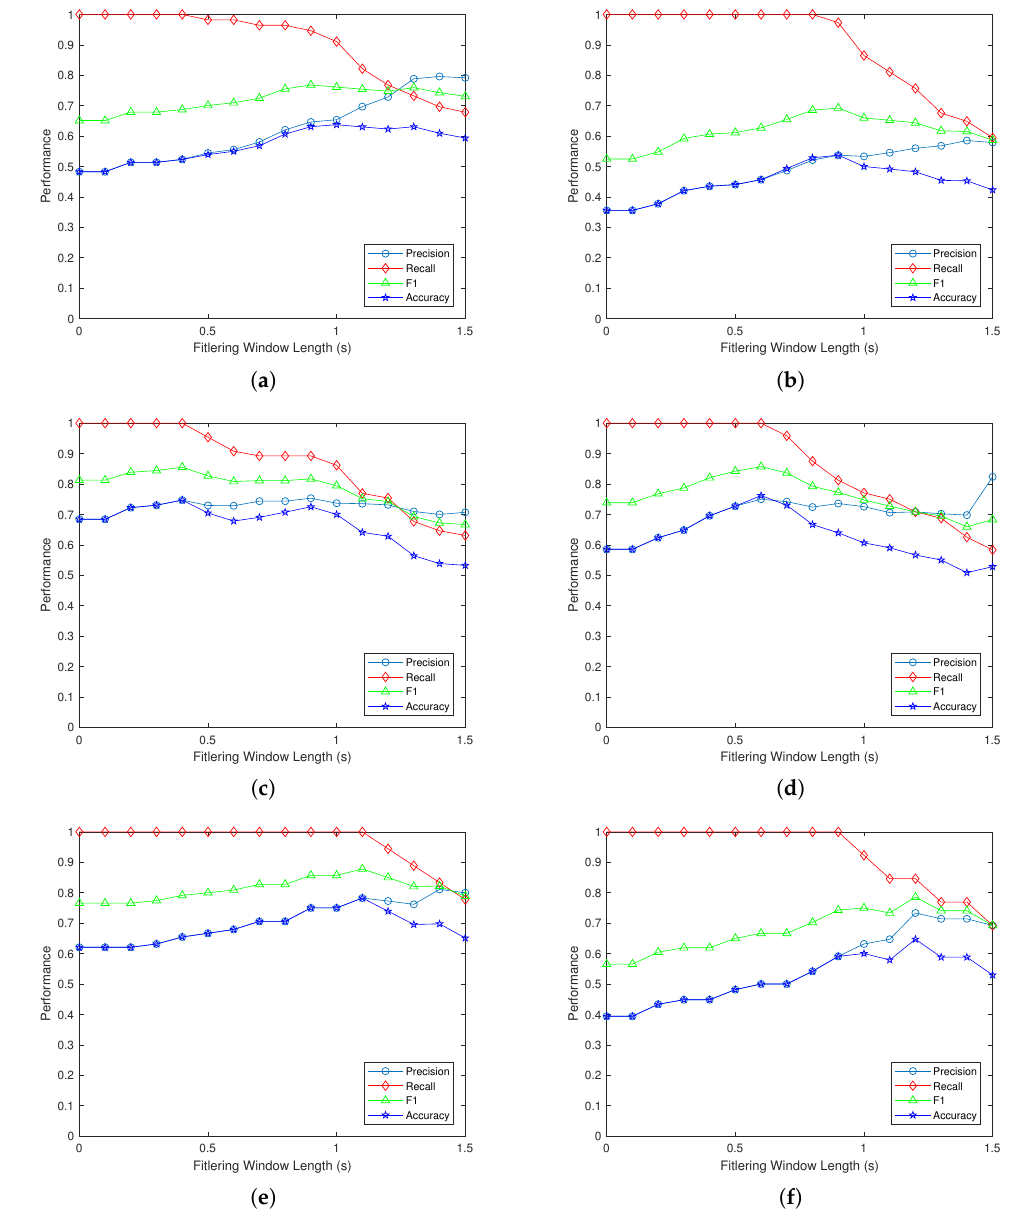
Figure 8. The impact of the time length of the filtering window on prediction performance in Dataset US-101. The left column shows the prediction performance of left lane changes, and the right column shows that of right lane changes. ( a ) Performance of left lane change in Dataset (IV); ( b ) Performance of right lane change in Dataset (IV); ( c ) Performance of left lane change in Dataset (V); ( d ) Performance of right lane change in Dataset (V); ( e ) Performance of left lane change in Dataset (VI); ( f ) Performance of right lane change in Dataset